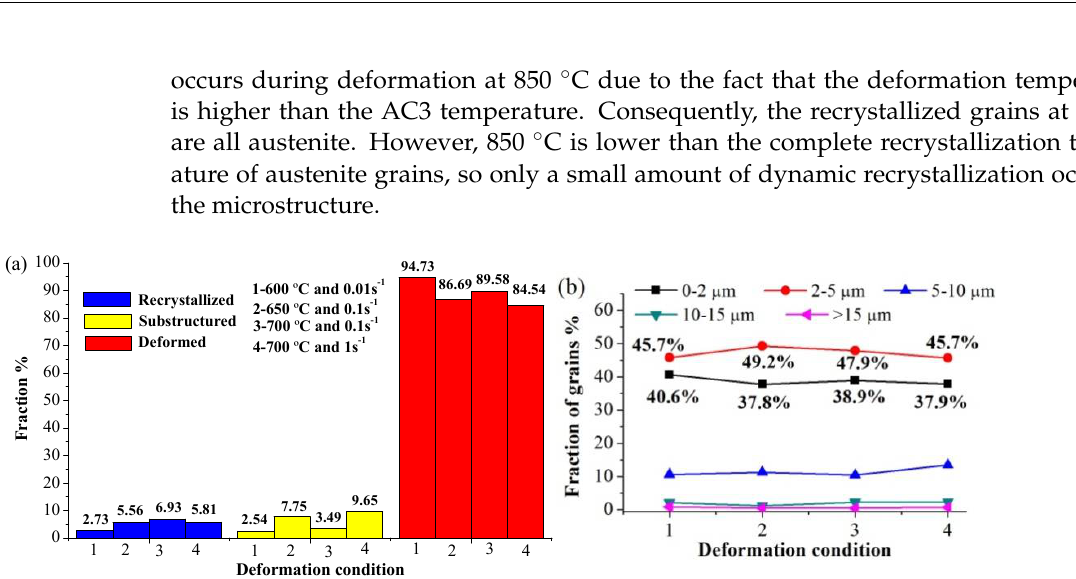
Figure 6. ( a ) The fraction of recrystallized, substructure and deformed grains under different defor- mation conditions ( b ) Distribution of grain size under different deformation conditions.